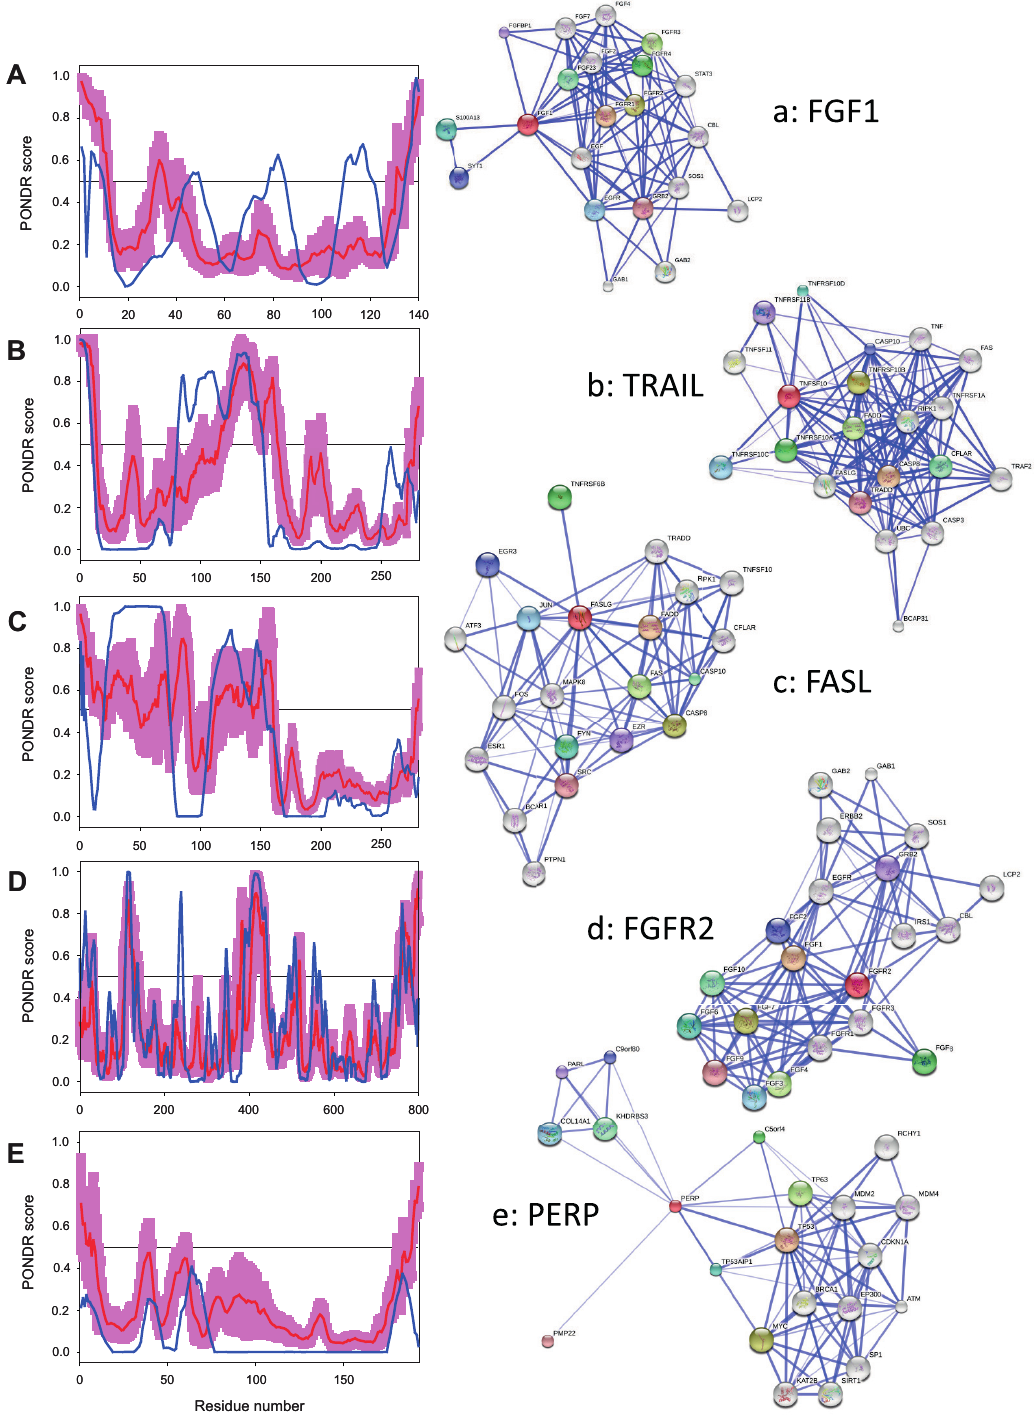
Figure 3. Intrinsic disorder (upper characters) of some human proteins involved in the p53-mediated apoptotic signaling pathways and STRING analysis (lower characters) of their interactomes: group I. A . and a . Growth/survival factor (Fibroblast growth factor 1, UniProt ID: P05230); B . and b . TRAIL (UniProt ID: P50591); C . and c . FasL (UniProt ID: P48023); D . and d . Growth factor receptor (Fibroblast growth factor receptor 2, UniProt ID: P21802); E . and e . PERP (UniProt ID: Q96FX8). Intrinsic disorder propensity was evaluated by PONDR-FIT (red curves and pink shadow) and PONDR ® VLXT (blue curves). The shadow around PONDR-FIT curves represents distribution of statistical errors. STRING database is the online database resource search tool for the Retrieval of Interacting Genes, which provides both experimental and predicted interaction information 92 . For each protein, STRING produces the network of predicted associations for a particular group of proteins. The network nodes are proteins. The edges represent the functional associations evaluated based on experiments, search of databases, and text mining. The thickness of edges is proportional to the confidence level 92